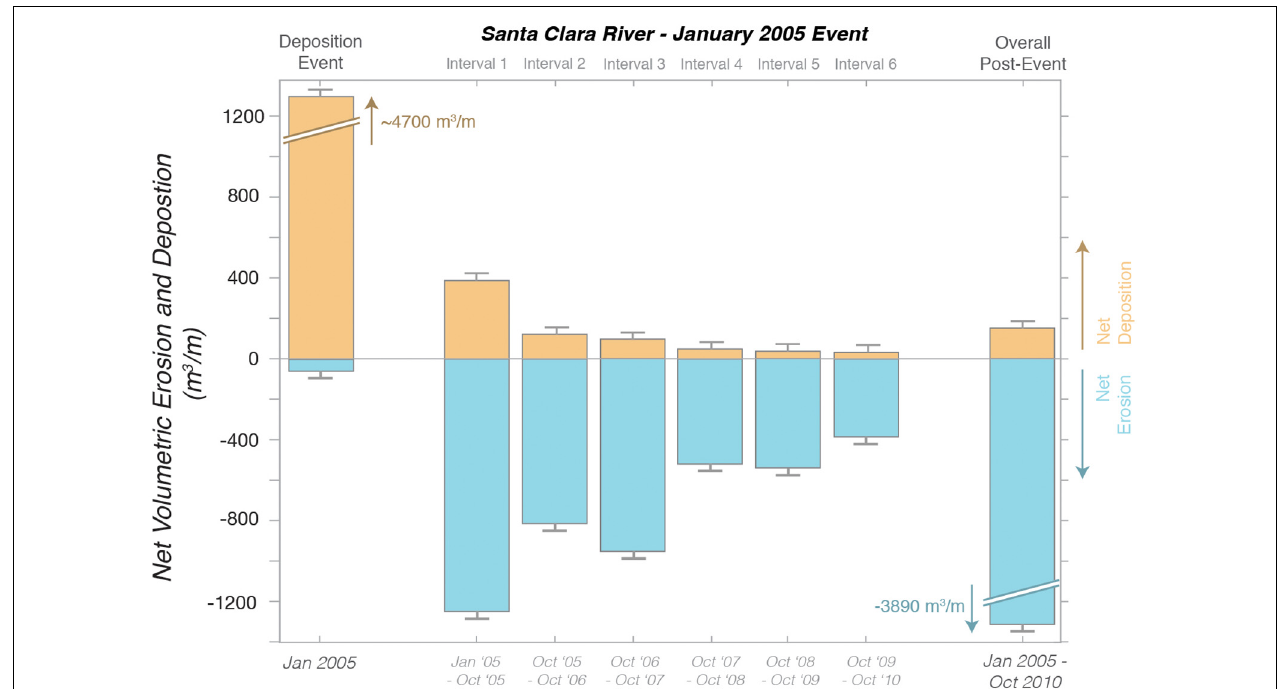
FIGURE 7 | Volumetric change along the profile of the Santa Clara River mouth for the January 2005 depositional event. Consistent with Figure 6 , both net deposition (orange) and net erosion (blue) are shown for each survey interval. Results are presented for the depositional event (left-hand side) survey-to-survey intervals (center) and for the overall survey record (right-hand side), and interval dates are shown below each plot. Error bars show the profile-length uncertainty ( ± 40 m 3 /m) in change measurements.